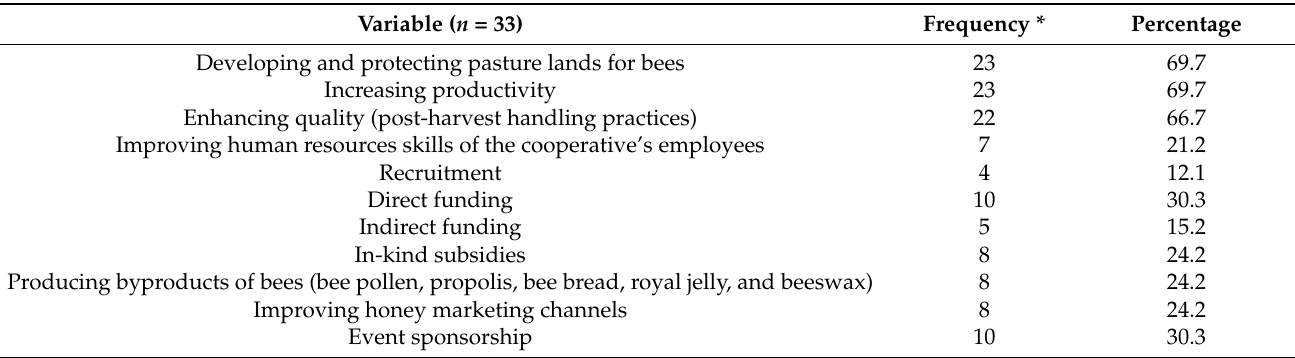
Table 9. Objectives of the partnerships